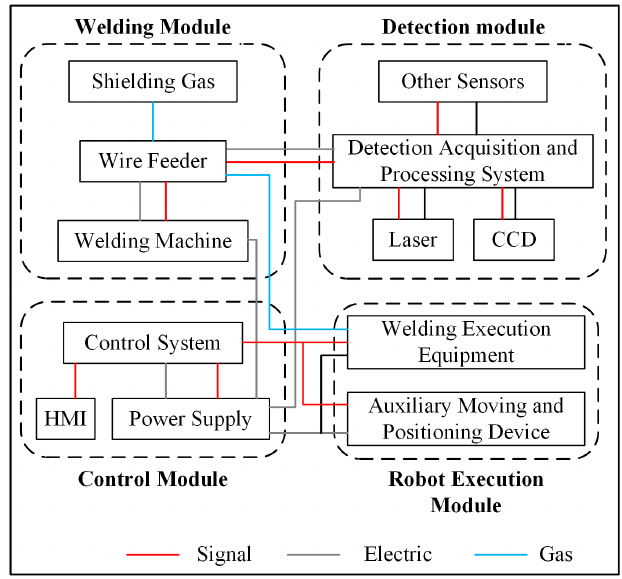
Figure 5. Welding additive manufacturing system framework.